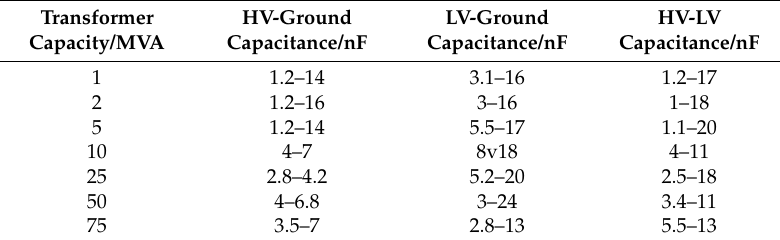
Table 2. Typical stray capacitances of transformers.